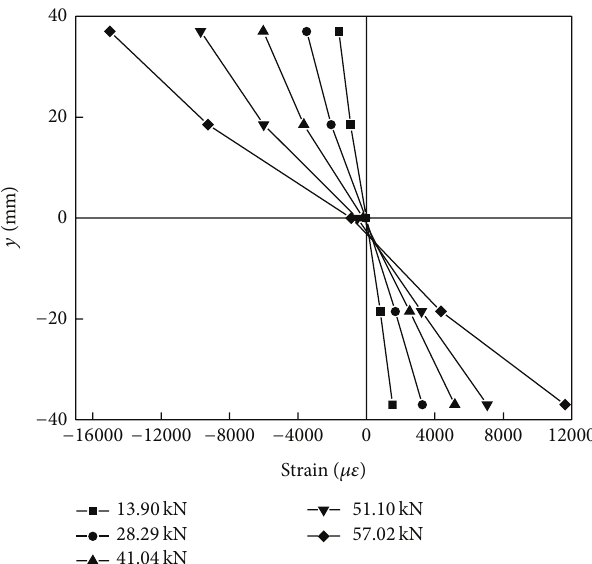
Figure 4: Load-strain typical curve of PSB